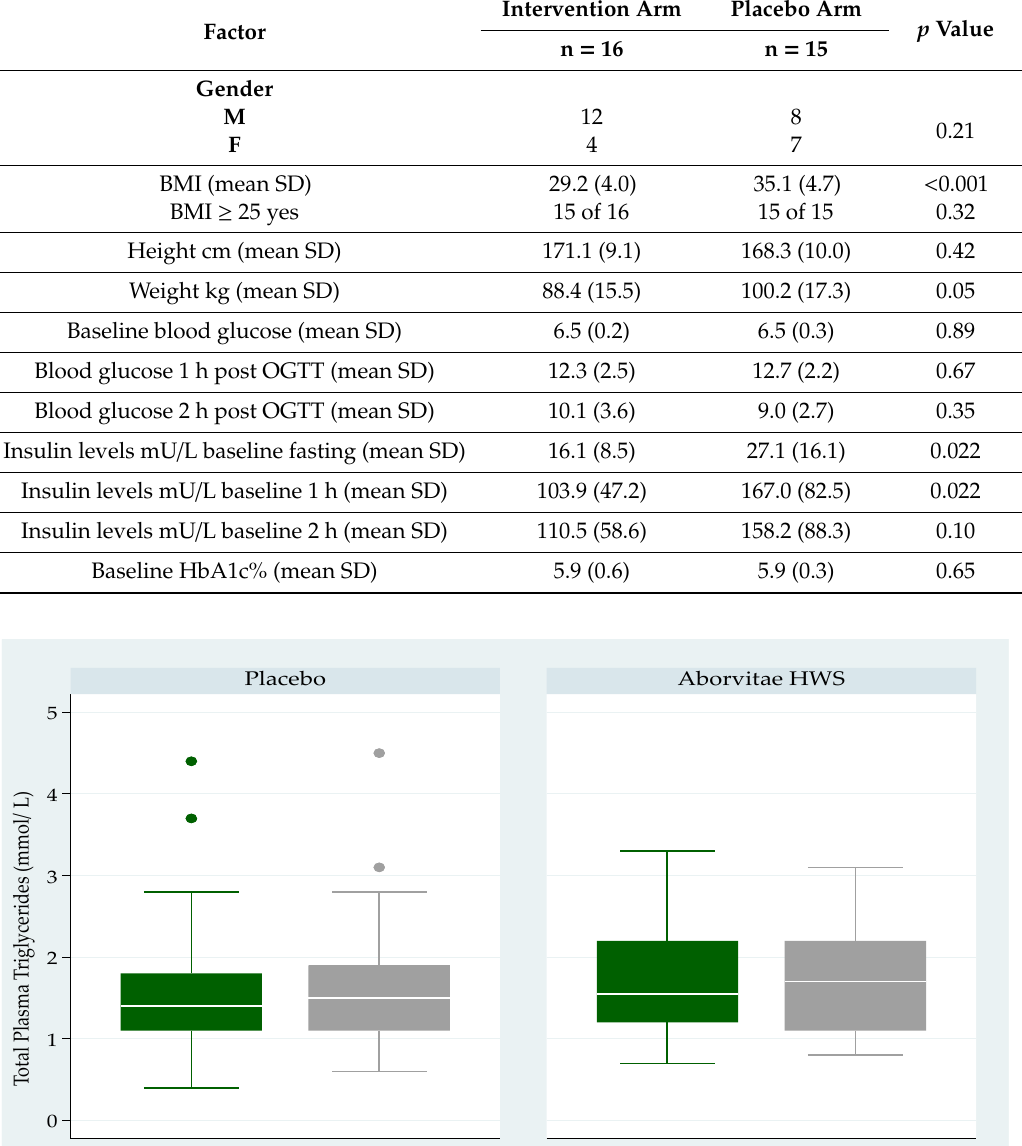
Table 7. Subgroup analysis of primary endpoint for participants with an FPG level in the range of 6.1–6.9 mmol / L.